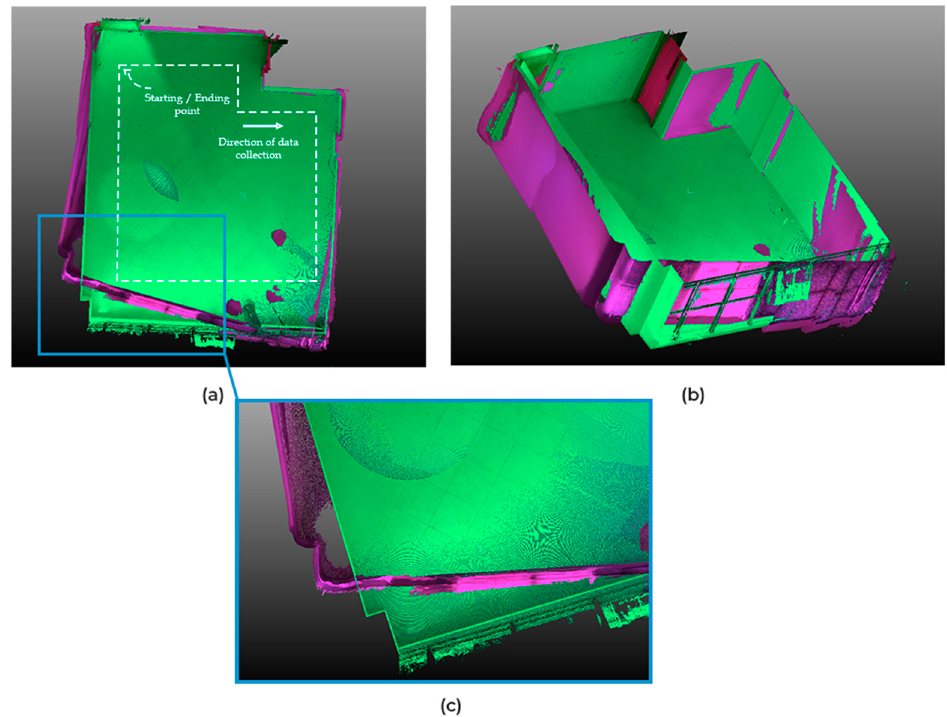
Figure 16. Odometry drift effect highlighted by superposing point clouds from TLS (green) and point clouds from Kinect Azure (purple). ( a ) Top view of the point clouds, indicating the start point and the trajectory. ( b ) Perspective view. ( c ) Zoom on a corner of the room to highlight the odometry drift.